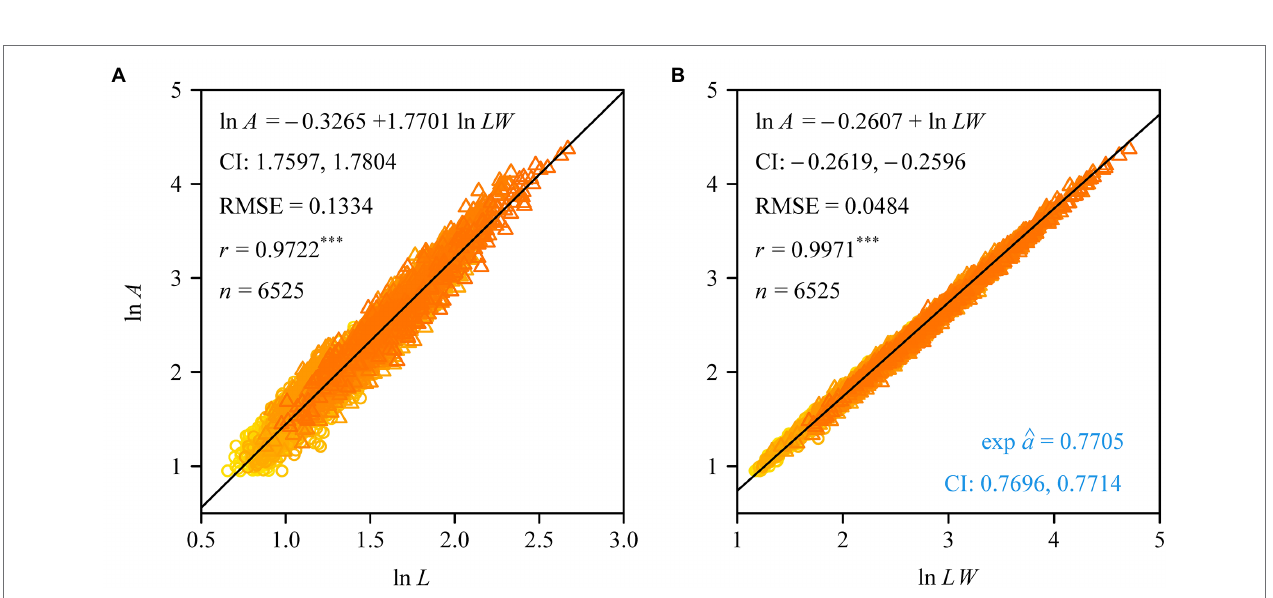
FIGURE 5 | Fitted results to the data of leaf area vs. leaf length (A) , and the data of leaf area vs. the product of leaf length and width (B) . In panel (A) , CI represents the 95% confidence intervals of the slope; in panel (B) , CI represents the 95% confidence intervals of the exponential of the intercept, i.e., the Montgomery parameter’s CI. RMSE is the root-mean-square error of the linear regression; r is the correlation coefficient, with three asterisks indicating p < 0.001; n is the sample size, i.e., the number of the pooled